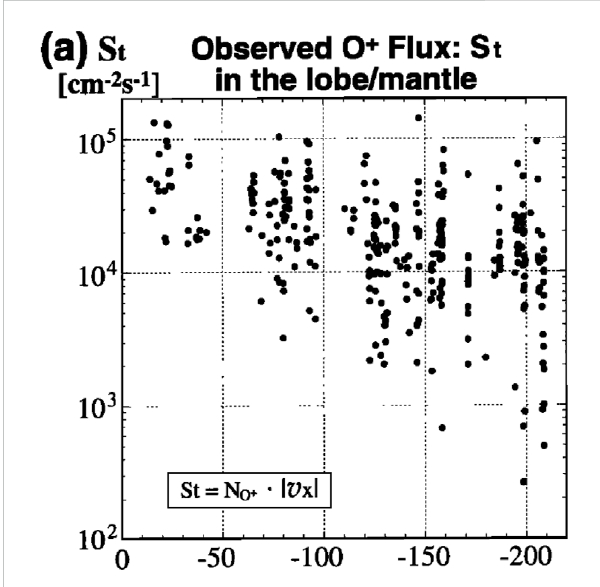
FIGURE 6 Cold O + beam fl uxes, observed by the Geotail spacecraft in the magnetotaillobeandplasmasheetboundarylayer, versus thetailward distance from the Earth (X GSM in R E ). The Moon is at X GSM ≈ − 60 R E (Earth radii). (From: Seki et al., 1998).